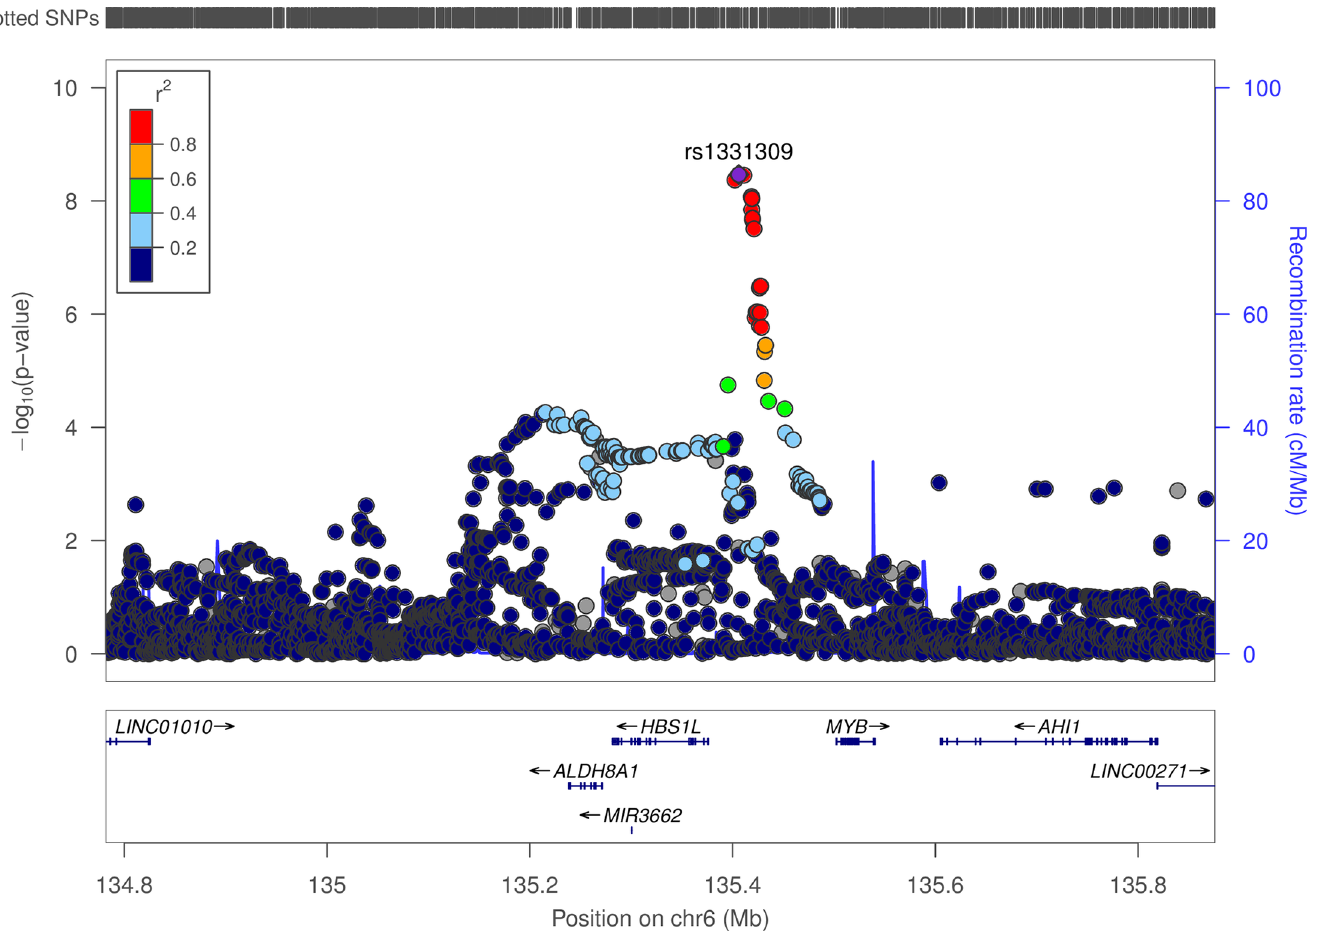
Fig 1. LD structure for variants associated with ELONG2_N6 in and near HBS1L